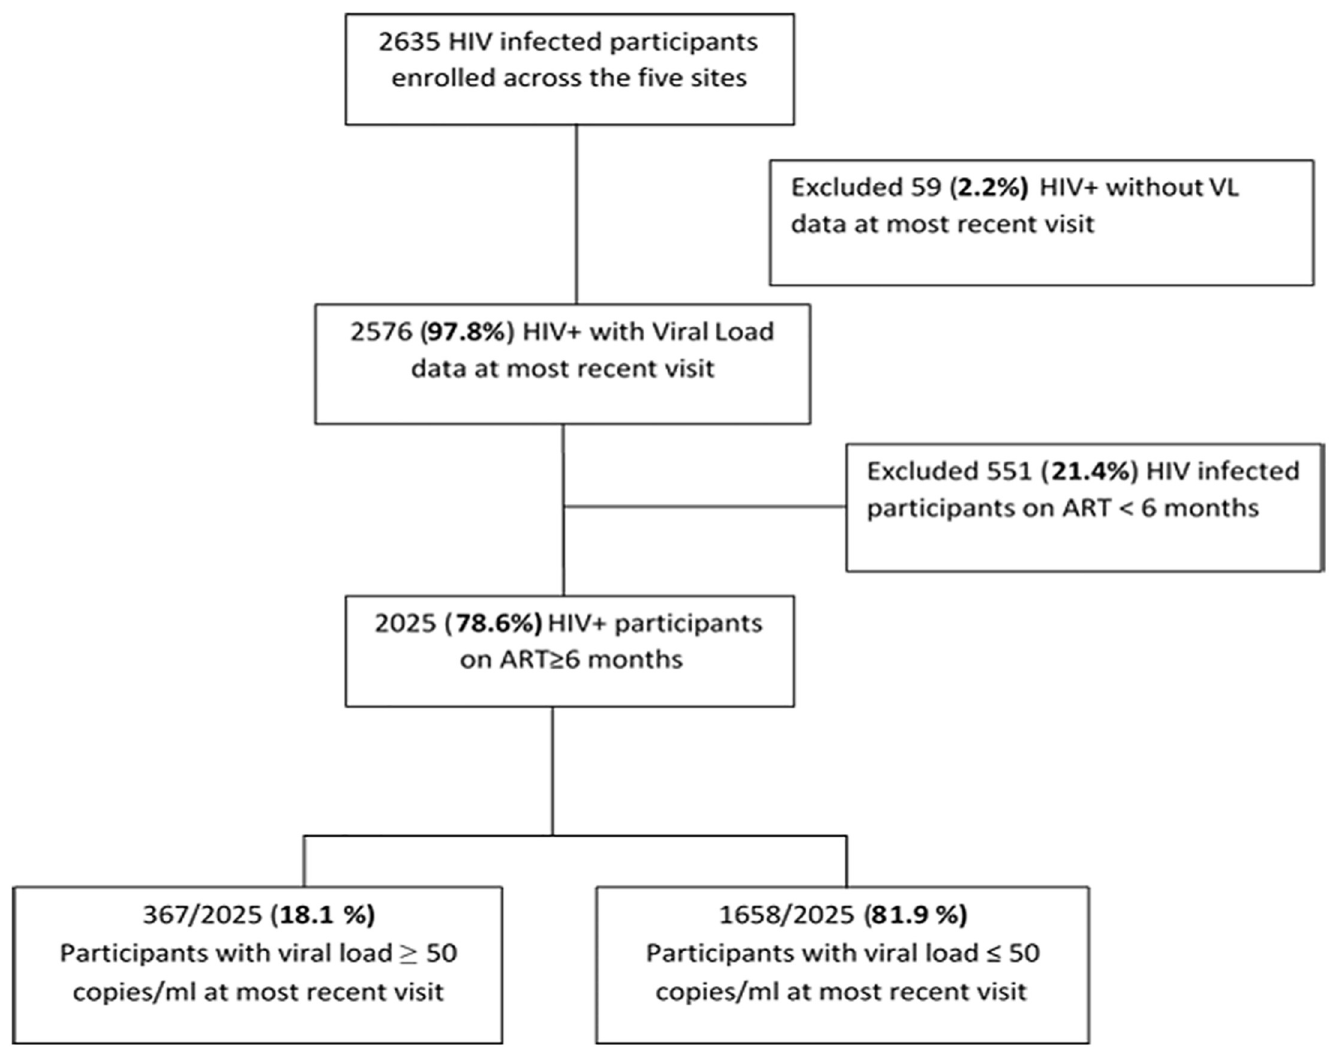
Fig 2. Flow diagram of AFRICOS participants included in the current